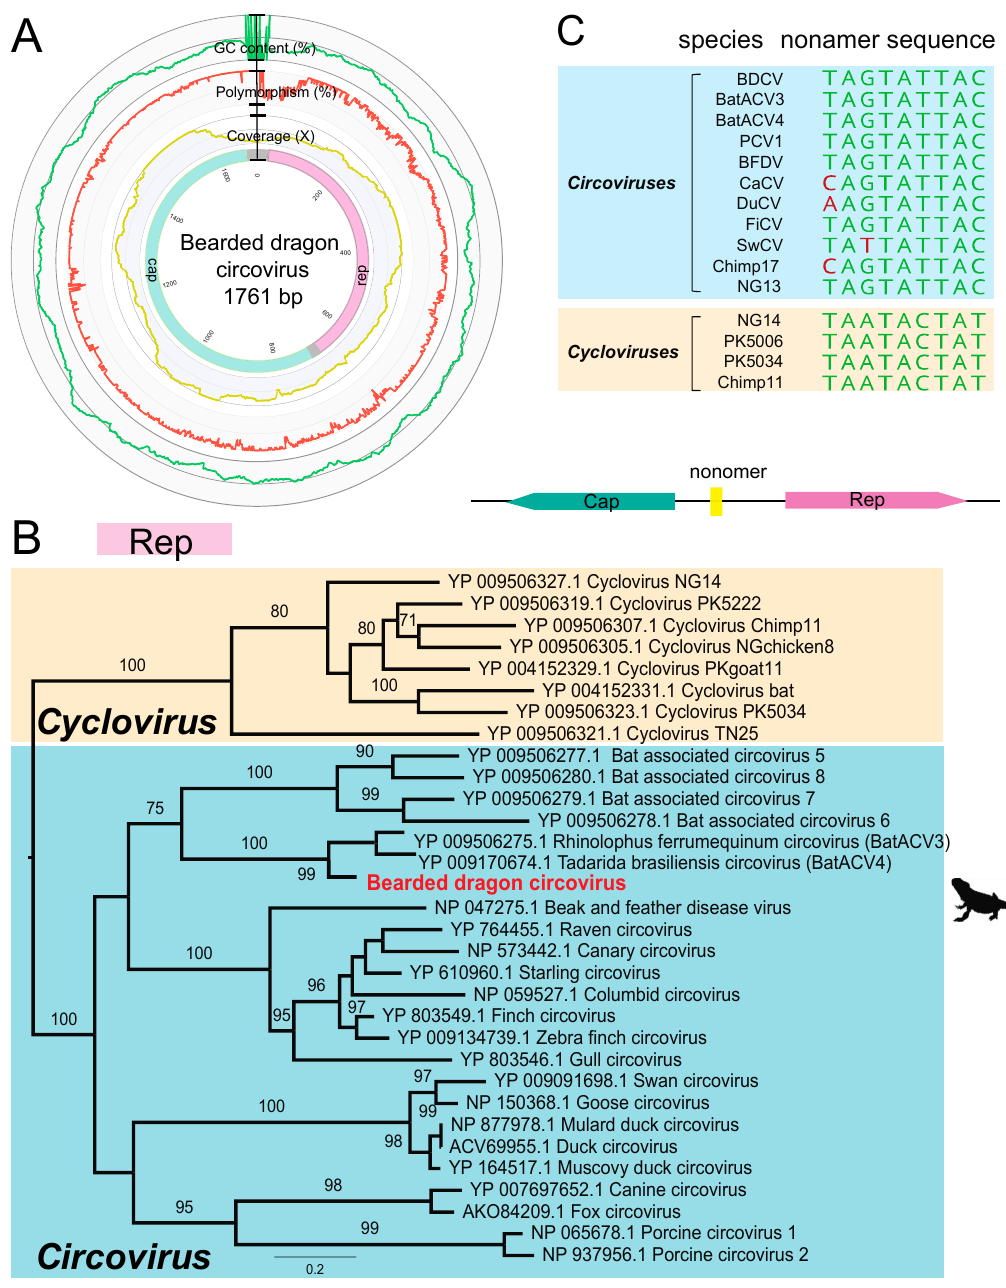
Figure 2. Genome characterization and phylogeny of bearded dragon circovirus. ( A ) Genome organization of bearded dragon circovirus. The outermost circles of the metadata ring represent the GC content (%, green), nucleotide polymorphism (%, orange), and read mapping coverage (yellow) of the genome. In the innermost circles, the proteins encoded by the replicase (Rep) and capsid protein (Cap) are labelled in pink and cyan, respectively. ( B ) Phylogenetic analysis of the Rep gene (nonstructural replicase protein) of circoviruses, including members of the Cyclovirus and Circovirus genera. Bootstrap values > 70% are presented for key nodes (1000 replicates). The tree was midpoint rooted for clarity only. Scale bar shows the number of substitutions per site. ( C ) Comparison of nonamer sequences with closely related viruses in the Circoviridae .